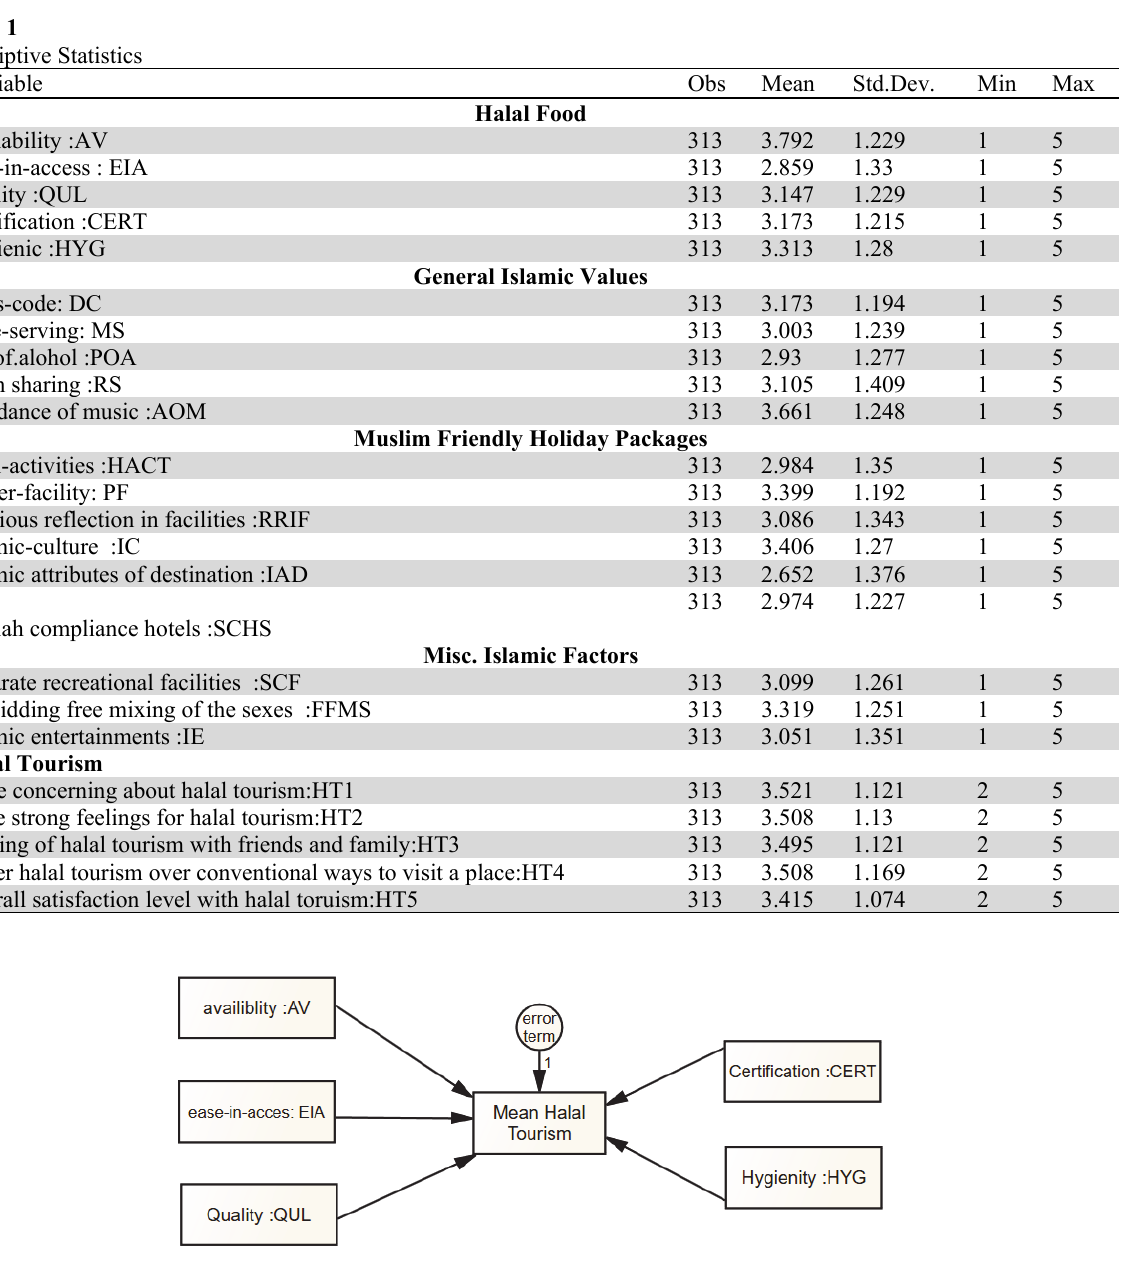
Fig. 1. Impact of Halal Food Characteristics on Halal Tourism Halal Food and Halal Tourism Mean HT